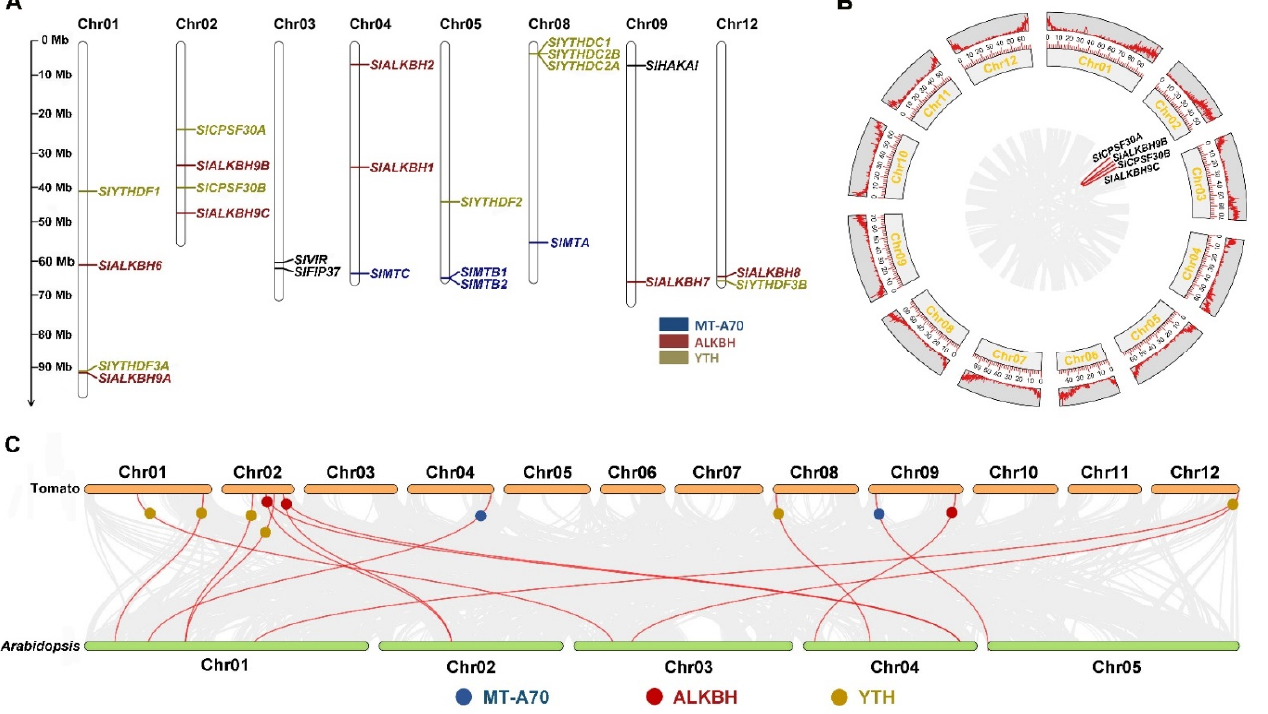
Figure 1. Chromosomal location and collinearity analysis of the m 6 A genes in tomato. ( A ) Locations of the m 6 A genes in tomato chromosomes. The scale at the left side of the figure is shown in Mb. The number of each chromosome is indicated at the top of the corresponding chromosome. ( B ) Synteny analysis of the m 6 A genes in tomato. The gray lines represent the collinearity result of the tomato genome, and the red lines represent the segmental duplication events. ( C ) Synteny analysis of the m 6 A genes between tomato and Arabidopsis . The gray lines represent the collinearity result between tomato and Arabidopsis genomes, and the red lines represent homologous gene pairs.